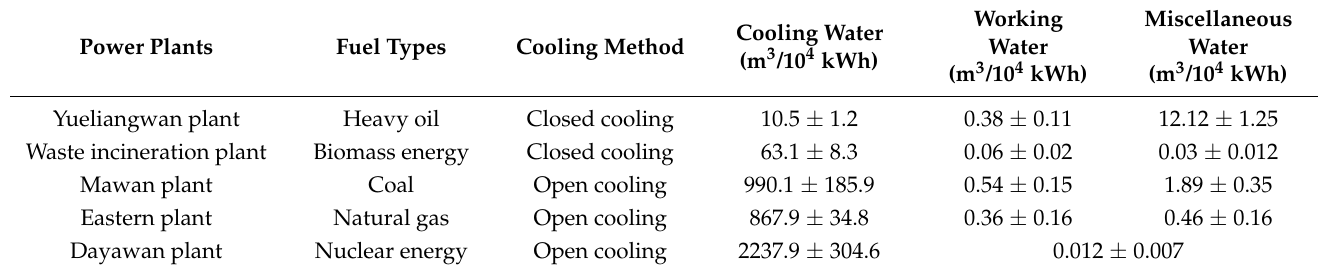
Table 3. Water consumption for electricity generation of typical power plants in